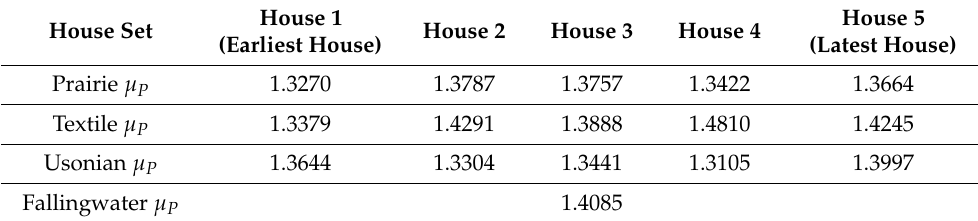
Figure 7. Linear trendline data for plans of the stylistic periods (arrayed, from left to right, in order from earliest to latest in each style), compared with Fallingwater. Table 5. All houses, plan data, in chronological order.